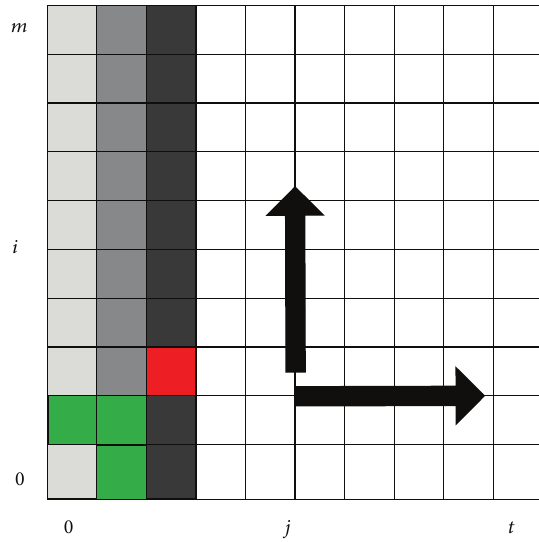
Figure 1: Column-wise fashion for computing matrix 𝐷